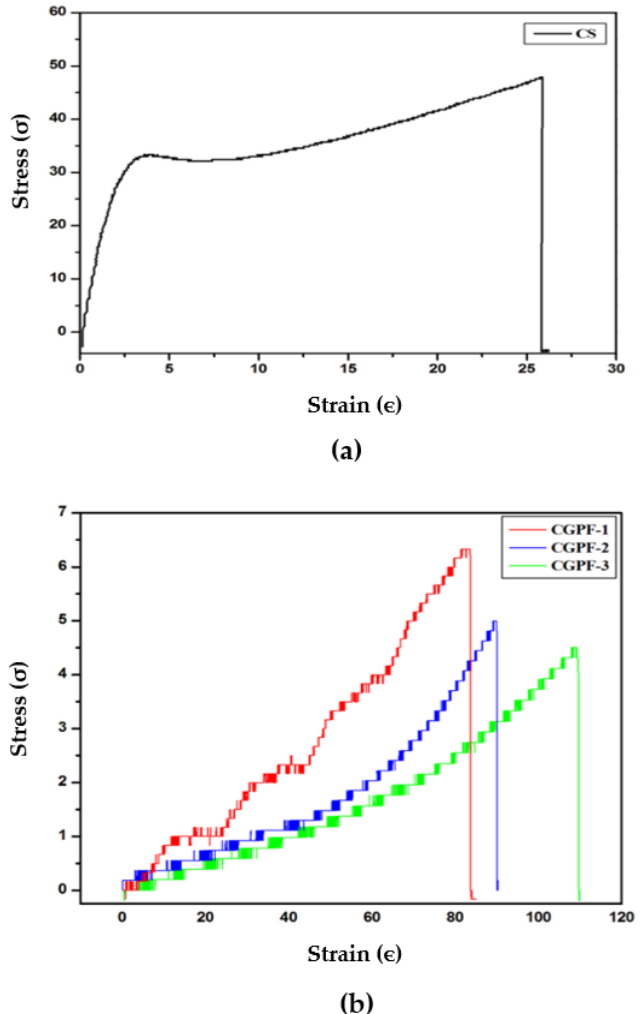
Figure 6. ( a ) Stress–strain curve of pure chitosan film. ( b ) Stress–strain curve of grafted chitosan film and GA-g–CS–Pt–Fe 3 O 4 nanoparticles nanocomposite films. Table 3. Tensile strength and testing of the chitosan and nanocomposites. Sample